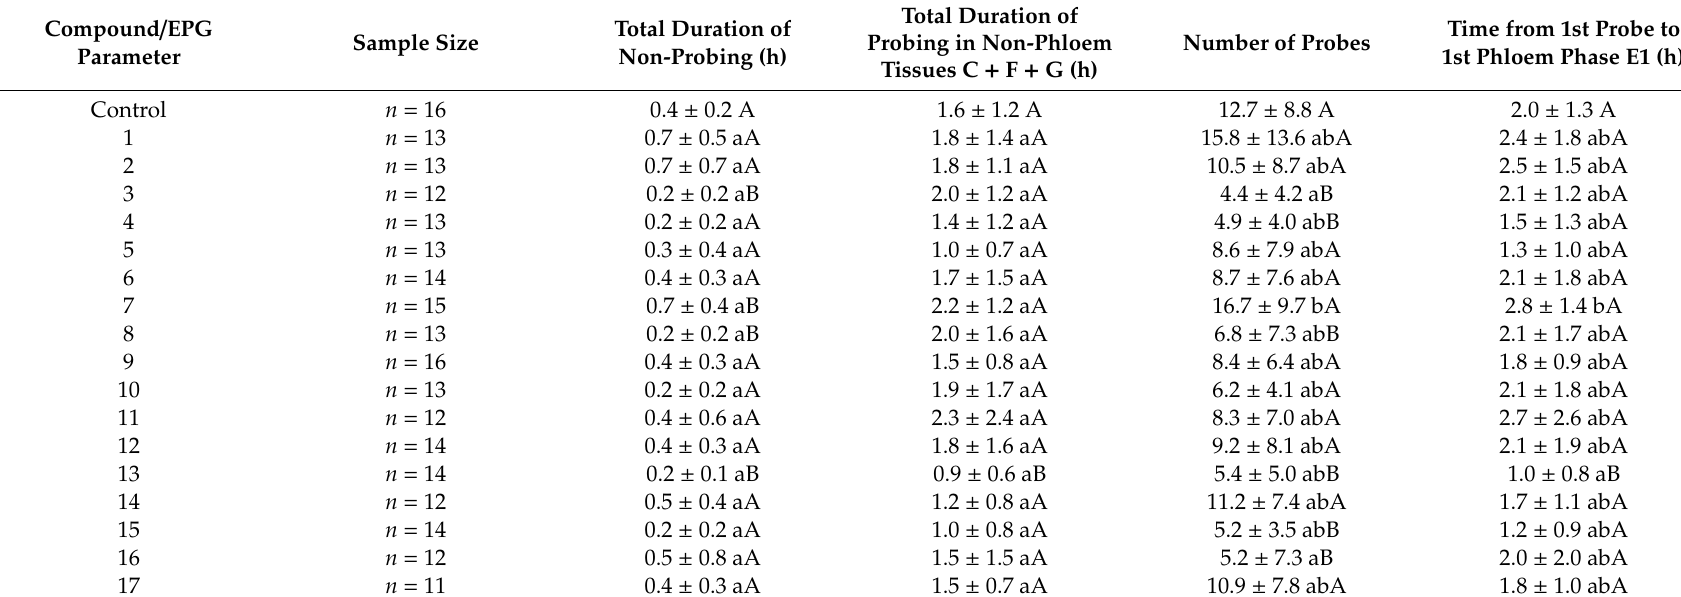
Table 2. Myzus persicae behavior in non-phloem tissues prior to the first phloem phase during probing on naringenin and naringenin derivatives ( 1 – 17 , Figures 1 and 2)- treated plants (means ± SD); the mean and SD values given are a representation of non-Gaussian data, but the statistical analysis was done by non-parametric tests, in which all individual data were included; n —number of replications; only replications where phloem phase occurred were included; C—pathway; E1—phloem salivation; F—derailed stylet movements; G—xylem sap ingestion. Di ff erent small letters in columns show significant di ff erences in the values of specific